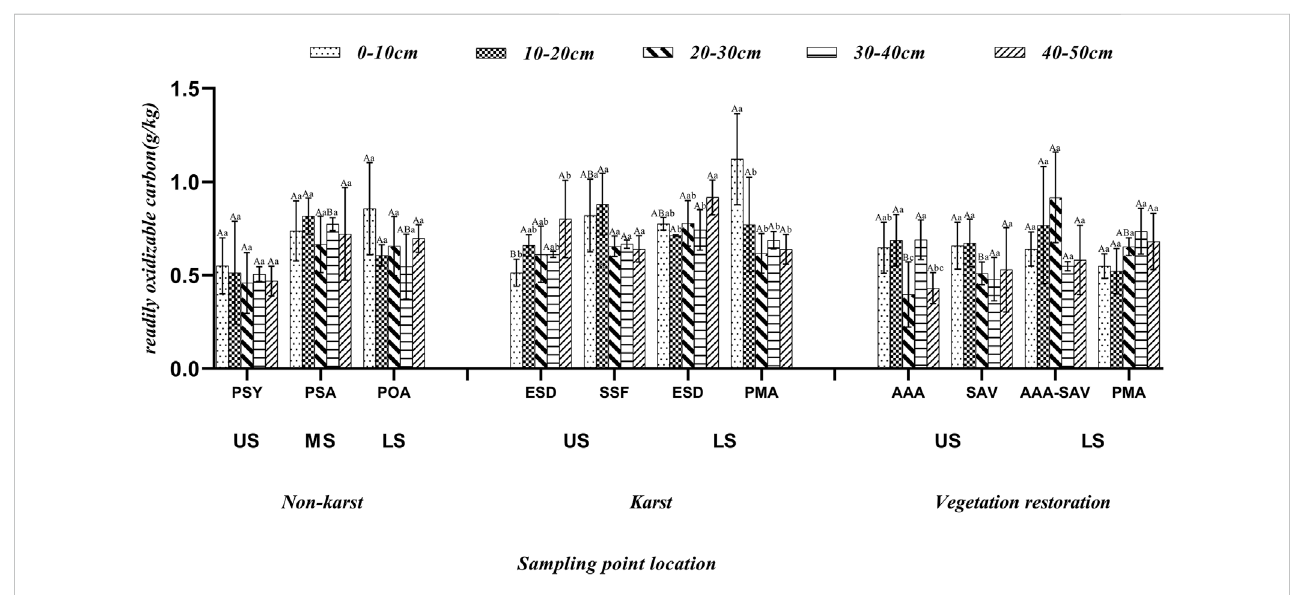
FIGURE 3 Content distribution characteristics of ROC in different bands.